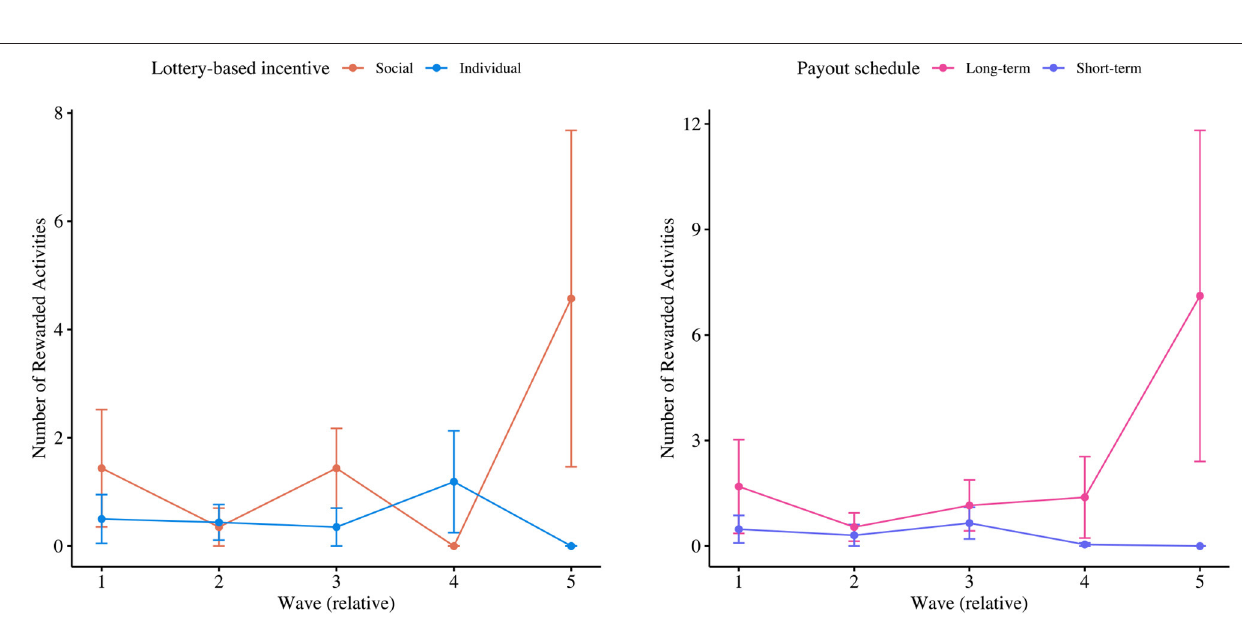
FIGURE 4 | Mean plots of the number of activities participants registered per type of incentive and per payout schedule,